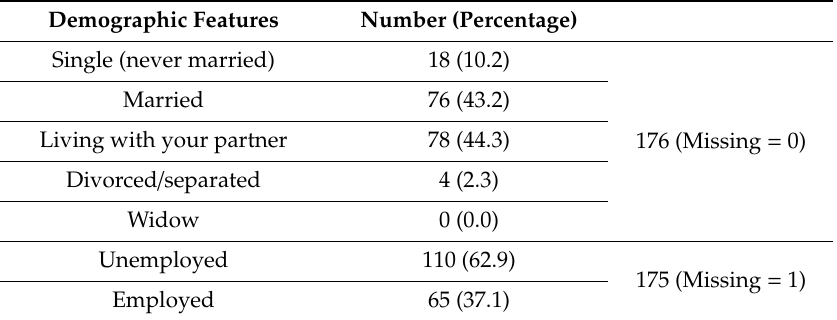
Table 4. Demographics of current